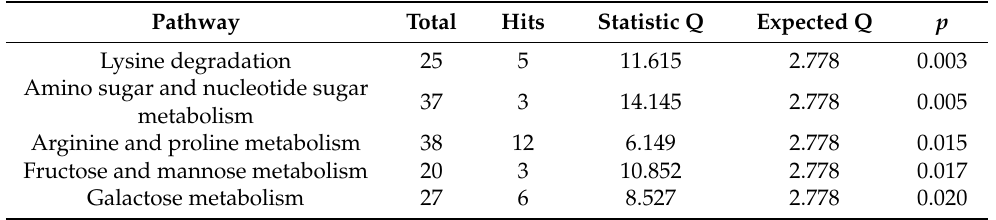
Table 2. Pathway enrichment analysis of metabolites. Only pathways with p < 0.05 are reported. Total represents the number of metabolites identified by KEGG in that pathway, and hits represents the number of metabolites associated in the present study.